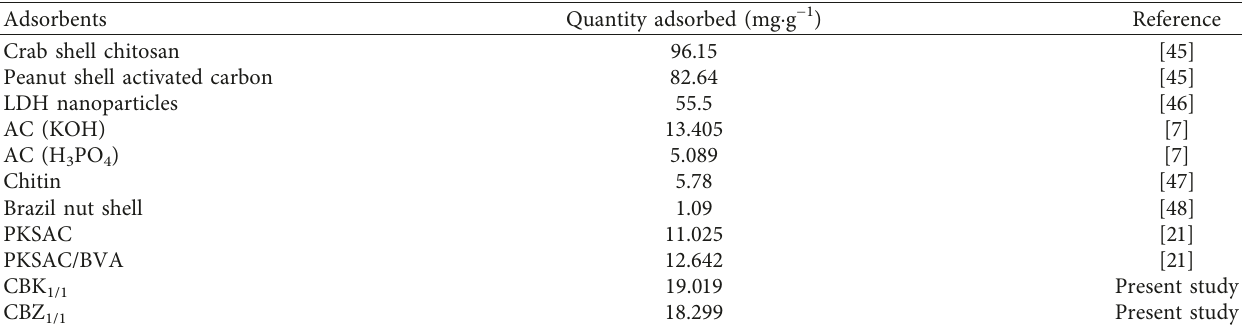
Table 8: Comparison of adsorption capacity of indigo carmine with other